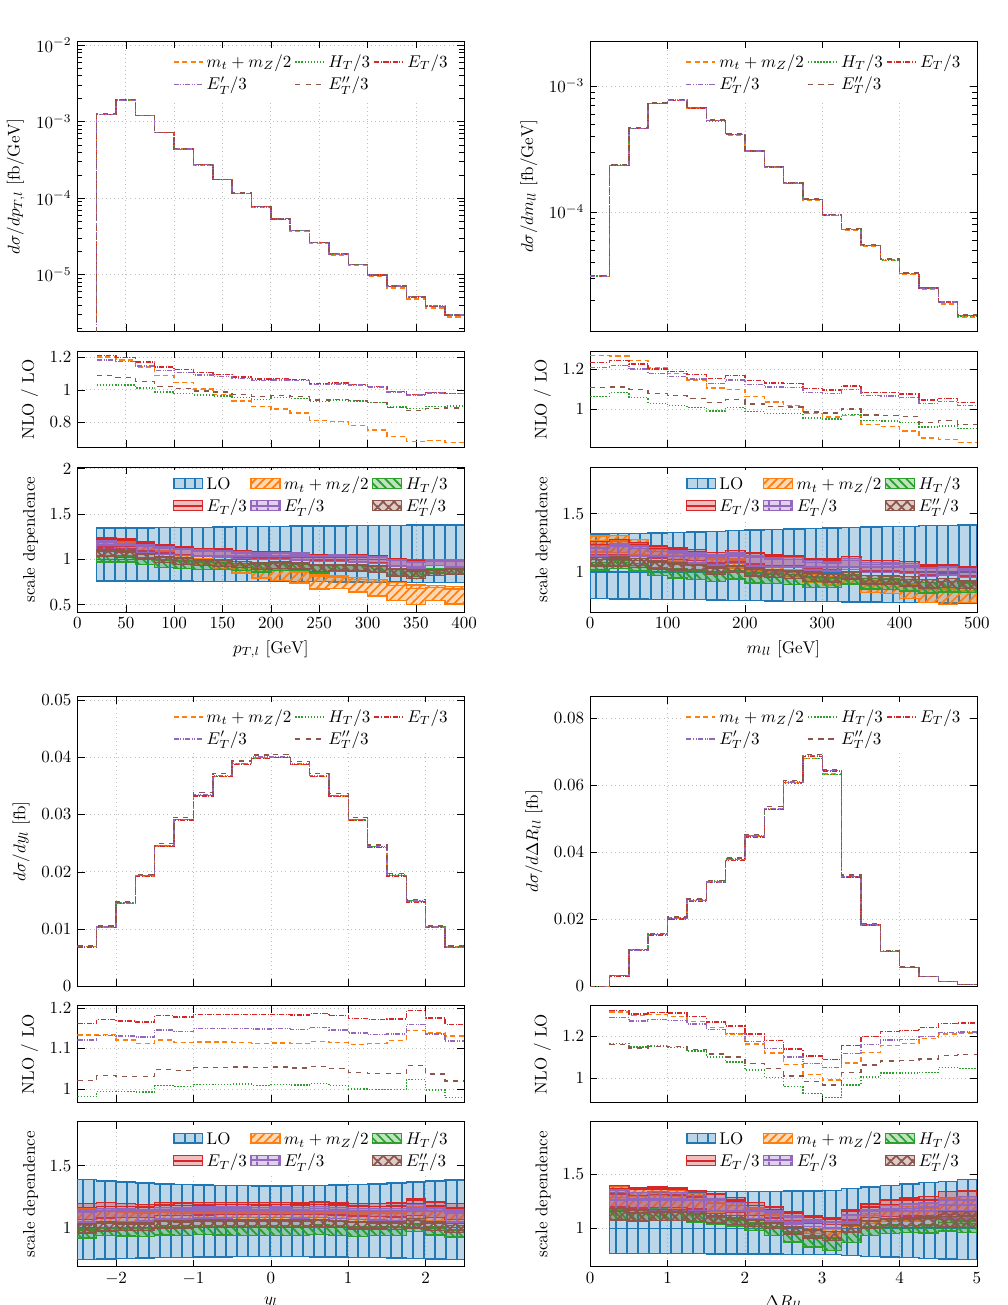
Figure 5 . The pp e + (cid:23) e (cid:22) (cid:0) (cid:22) (cid:23) (cid:22) b (cid:22) b (cid:23) (cid:28) (cid:22) (cid:23) (cid:28) + X di(cid:11)erential cross section distribution as a function of ! (averaged) p T;‘ , m ‘‘ , (averaged) y ‘ and (cid:1) R ‘‘ at the LHC run II with p s = 13 TeV. The upper plots show absolute NLO QCD predictions for various values of (cid:22) 0 where (cid:22) R = (cid:22) F = (cid:22) 0 . The middle panels display di(cid:11)erential factors. The lower panels present di(cid:11)erential factors together K K with the uncertainty band from the scale variation for various values of (cid:22) 0 . Also given is the relative scale uncertainties of the LO cross section for (cid:22) 0 = m t + m Z = 2. The LO and the NLO CT14 PDF sets are employed.